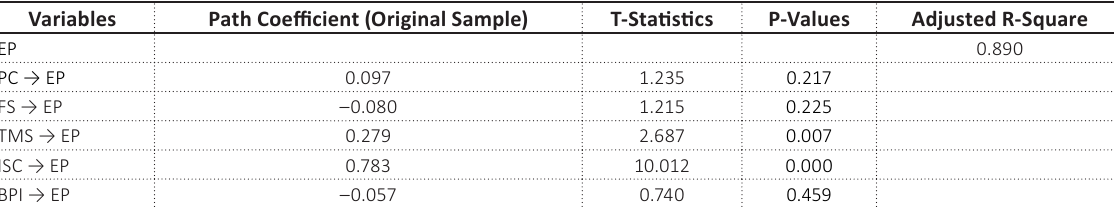
Table 7. PLS path algorithm and